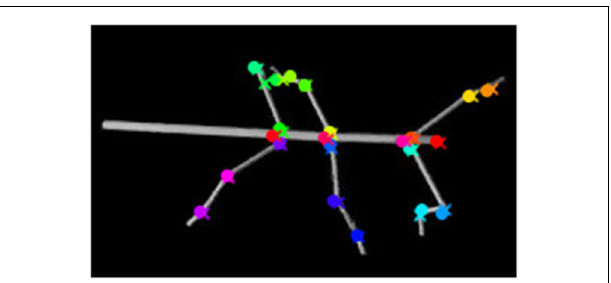
FIGURE 9 | Occlusion of body parts. Here the tarsus of the left hind leg (dark green cross) is occluded by the hind leg femur. The network mistakes the tarsus of the middle leg (light green cross) as the tarsus of the hind leg (dark green circle). The ground truth is marked by crosses, whereas circles mark network